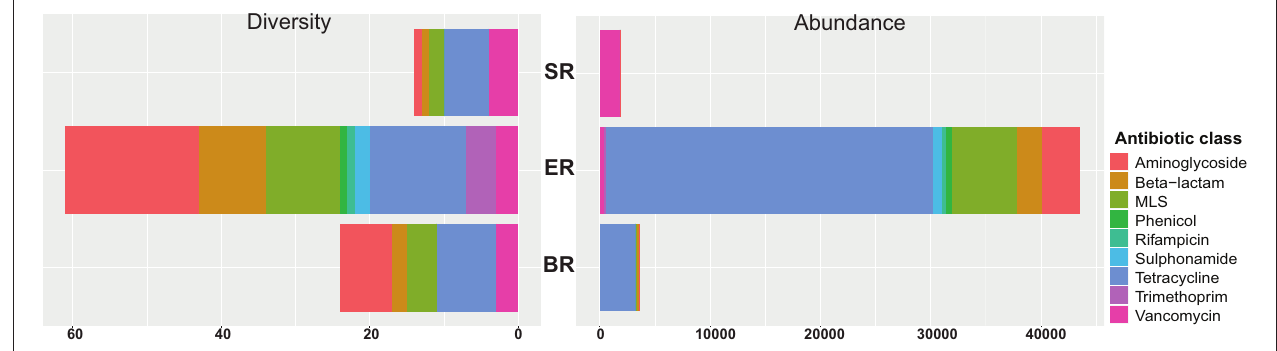
FIGURE 6 | Resistome profiling of wild and zoo-captive monkeys. The diversity measures indicate the number of AMR genes detected from the ResFinder database in each class. Abundance was calculated based on the sum RPK of each class of AMR makers per metagenome.